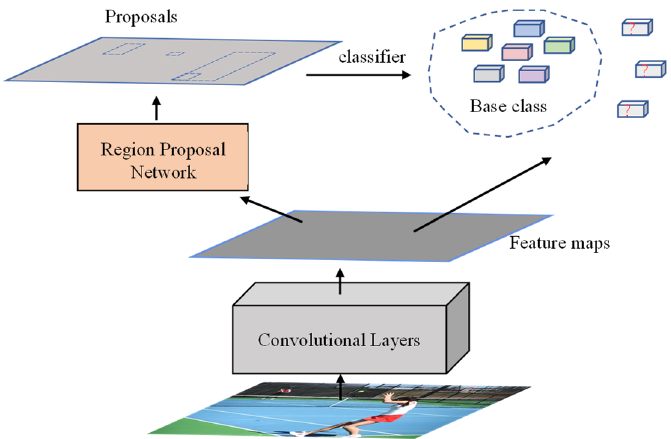
Figure 2. Framework of our detector. Potential regions of objects from the feature maps, which are represented with bounding box coordinates, are proposed by RPN. Objects of base classes are easy to be recognized. It is difficult to recognize objects of novel classes or objects with few features.